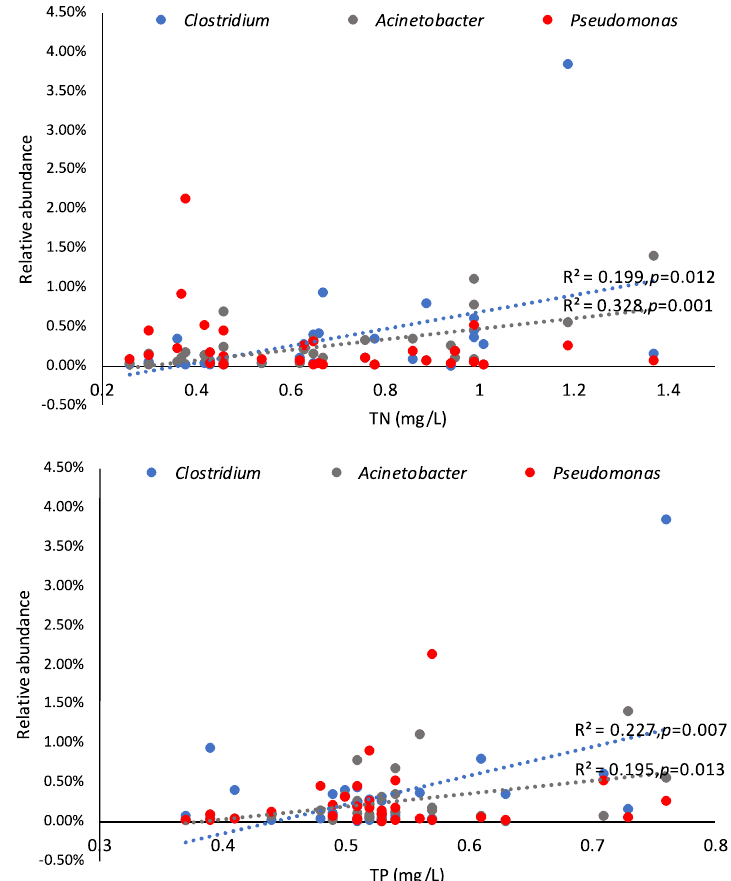
Figure 8. Relationships between nutrients and the relative abundance of dominant fecal bacteria. Significant ordinary least squares (OLS) regression lines were fit to the data. The blue and grey dash lines represent Clostridium and Acinetobacter , respectively. Statistical significances are indicated by p ‐ values.